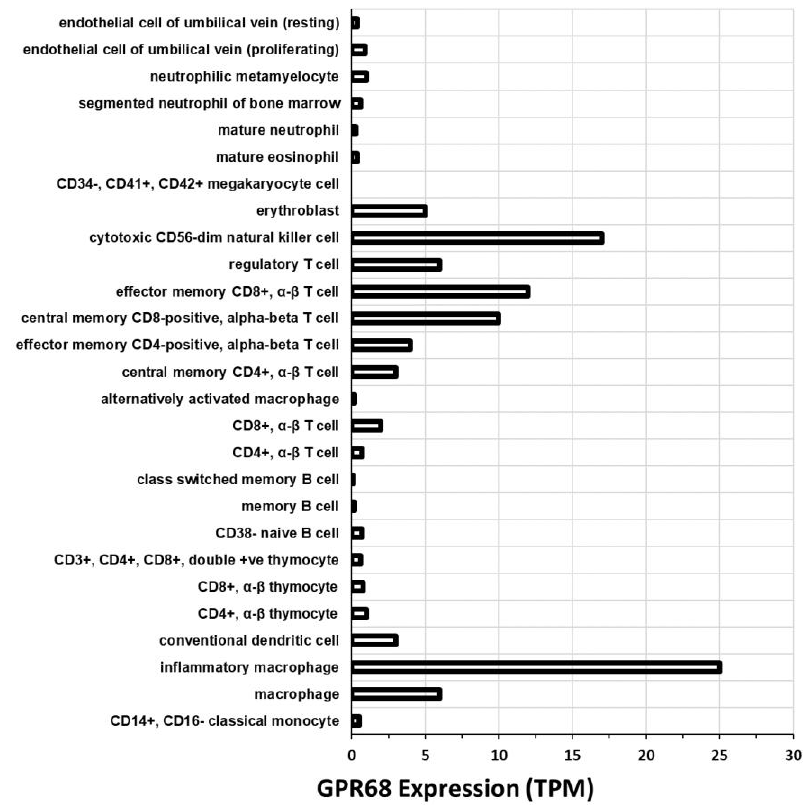
Figure 6. GPR68 expression in hematopoietic cells. These data are from the Blueprint Consortium, hosted at the EMBL-EBI expression atlas, and show GPR68 expression in transcripts per million (TPM) in a variety of cell types.